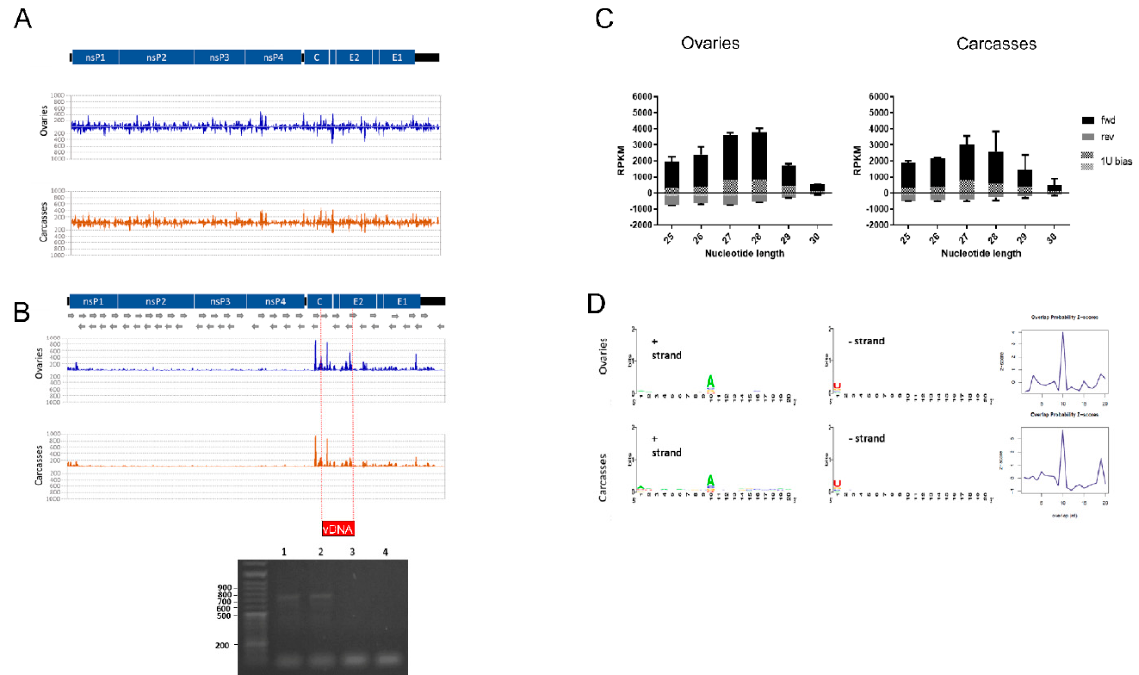
Figure 2. Small RNA response against the infecting CHIKV. ( A ) siRNA profile along the CHIKV genome. Values on the y-axis represent quantification of the signal as Reads Per Kilobase Million (RPKM). ( B ) piRNA profile along the CHIKV genome and PCR amplification of the vDNA fragment. Wells 1 and 2 show the PCR results from the DNA of the two biological replicates of CHIKV-infected ovaries; wells 3–4 show the PCR results from the DNA of the corresponding un- infected controls. The red box indicates the position in which the vDNA fragment was identified. ( C ) Read size distribution of piRNA reads in forward (black), reverse (grey), and displaying 1U bias (dots). ( D ) Nucleotide bias at each position of piRNAs against CHIKV mapping to the sense (+) strand (left panel) and antisense ( − ) strand (right panel) in ovaries and carcasses, and corresponding PingPong overlap probabilities.